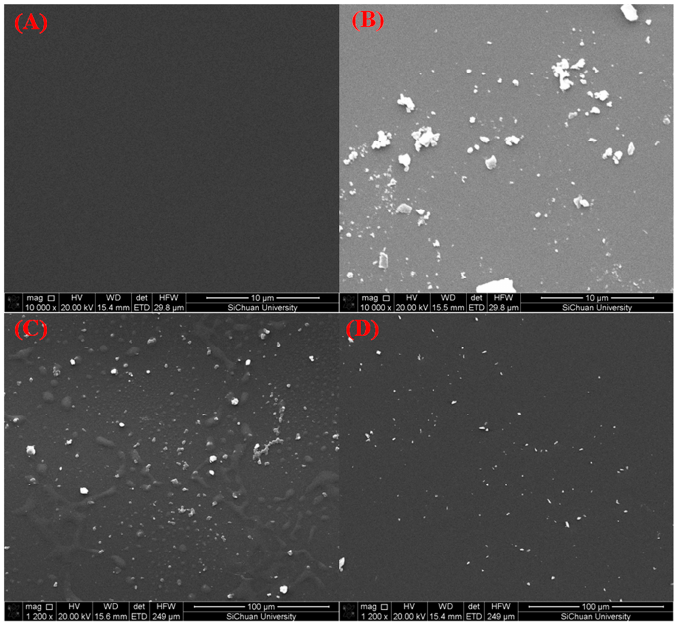
Figure 7. SEM photographs of PI films from LC cells with 0 wt % DA monomers ( A ), 2 wt % DA monomers ( B ), 1 wt % DA monomers ( C ), and 0.5 wt % DA monomers ( D ) after UV irradiation and thermal annealing at 120 °C for 30 min.